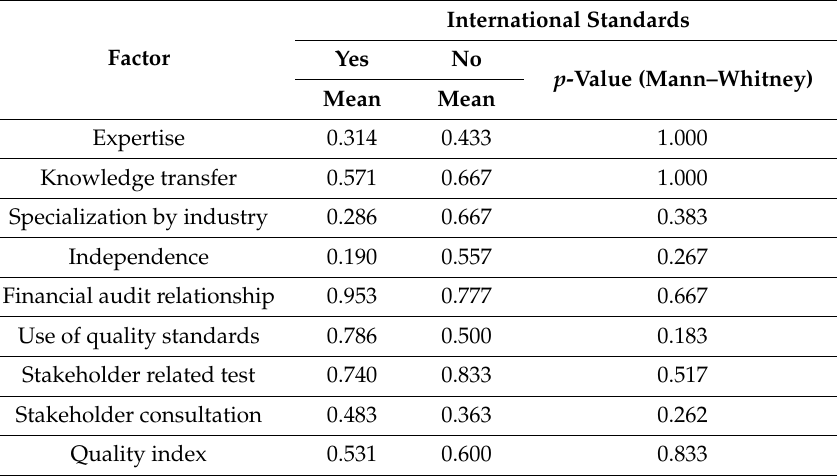
Table 10. Assurance quality vs. international